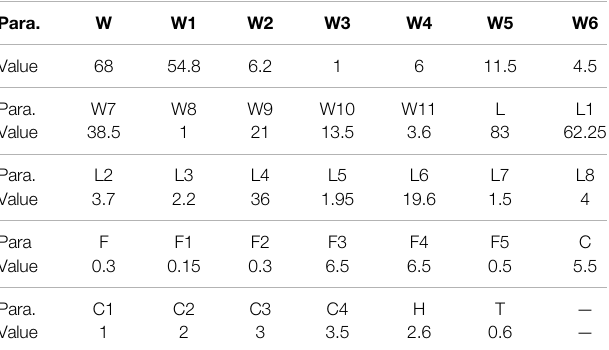
TABLE 1 | Antenna parameters